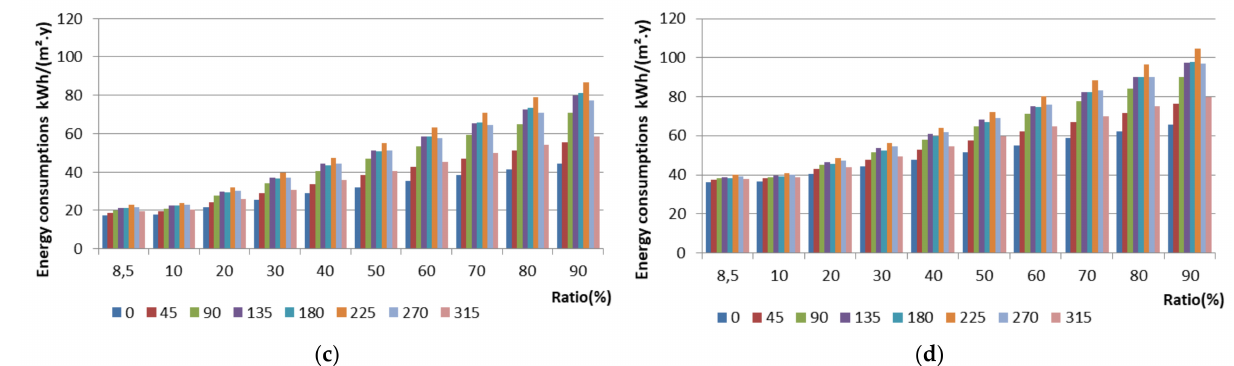
Figure 5. Electric energy consumptions for laminated glazing as a function of different orientations and WWR kWh/(m 2 .y). ( a ) Heating. ( b ) Lighting. ( c ) Cooling. ( d ) Overall